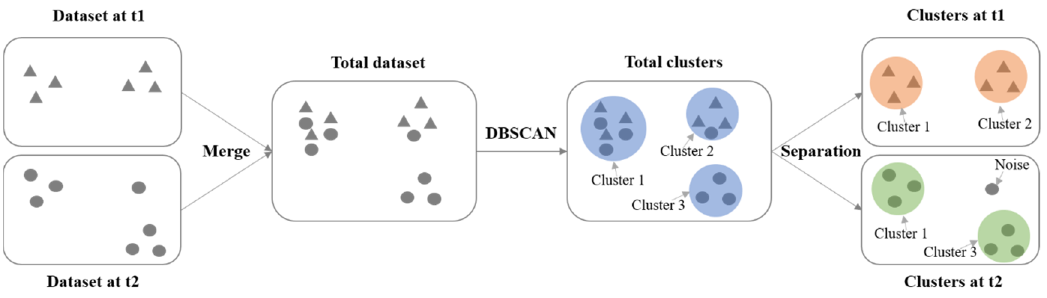
Figure 4. Clustering flowchart for two datasets.